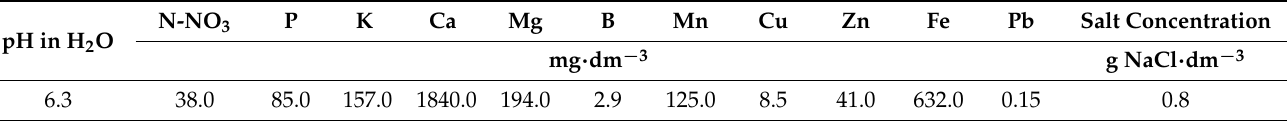
Table 3. Chemical composition of soil under tomatillos in the first year of the